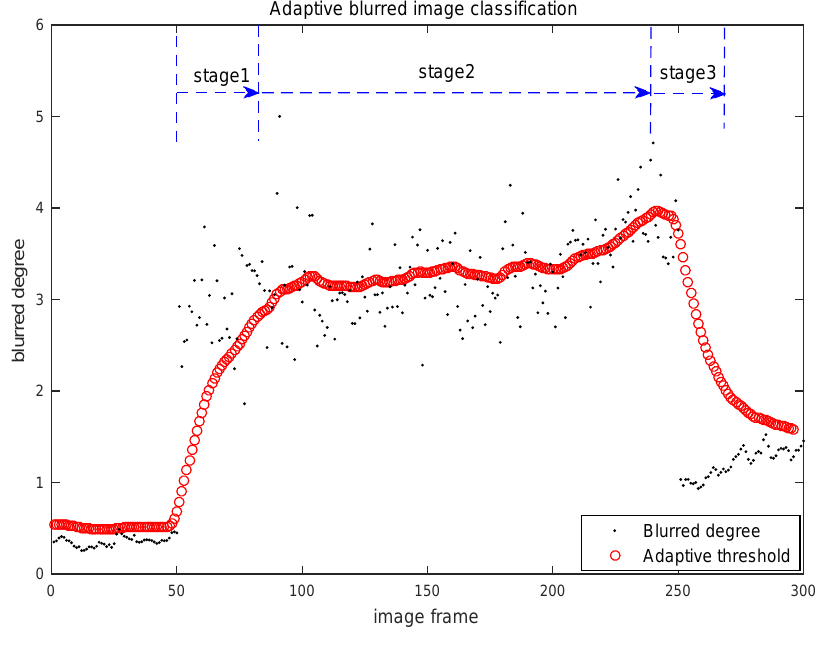
Figure 9. Blurred image classification results on the noised NewCollege data set.